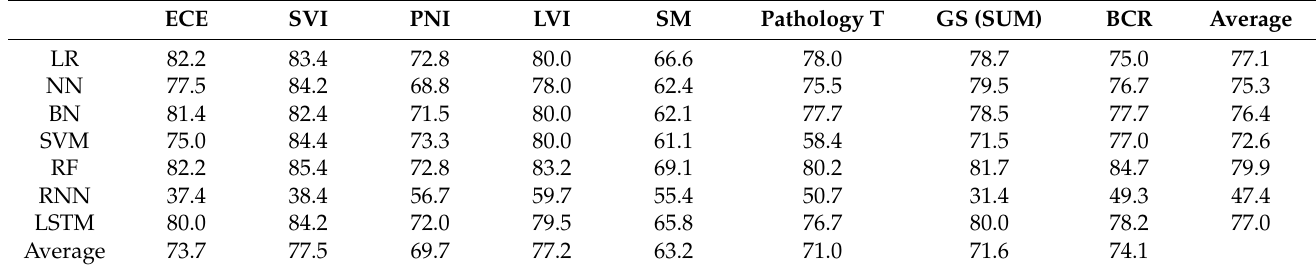
Table 4. Accuracy of the eight ML models